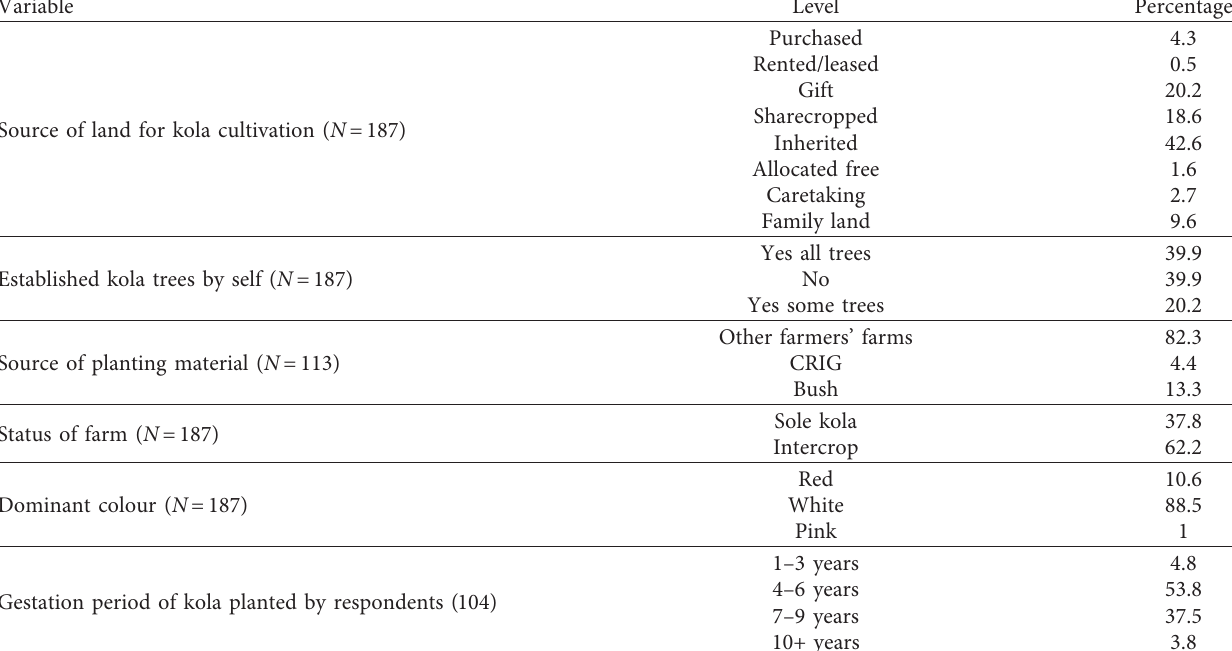
Table 3: Characteristics of kola